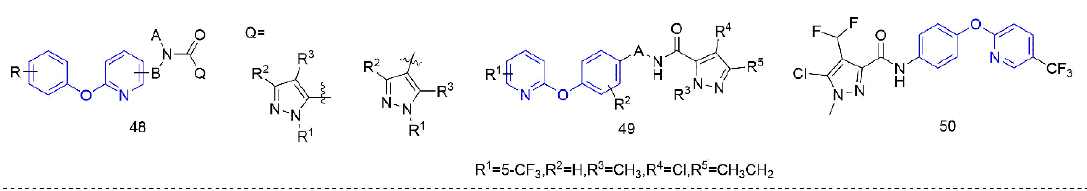
Figure 9. Succinate dehydrogenase inhibitors containing